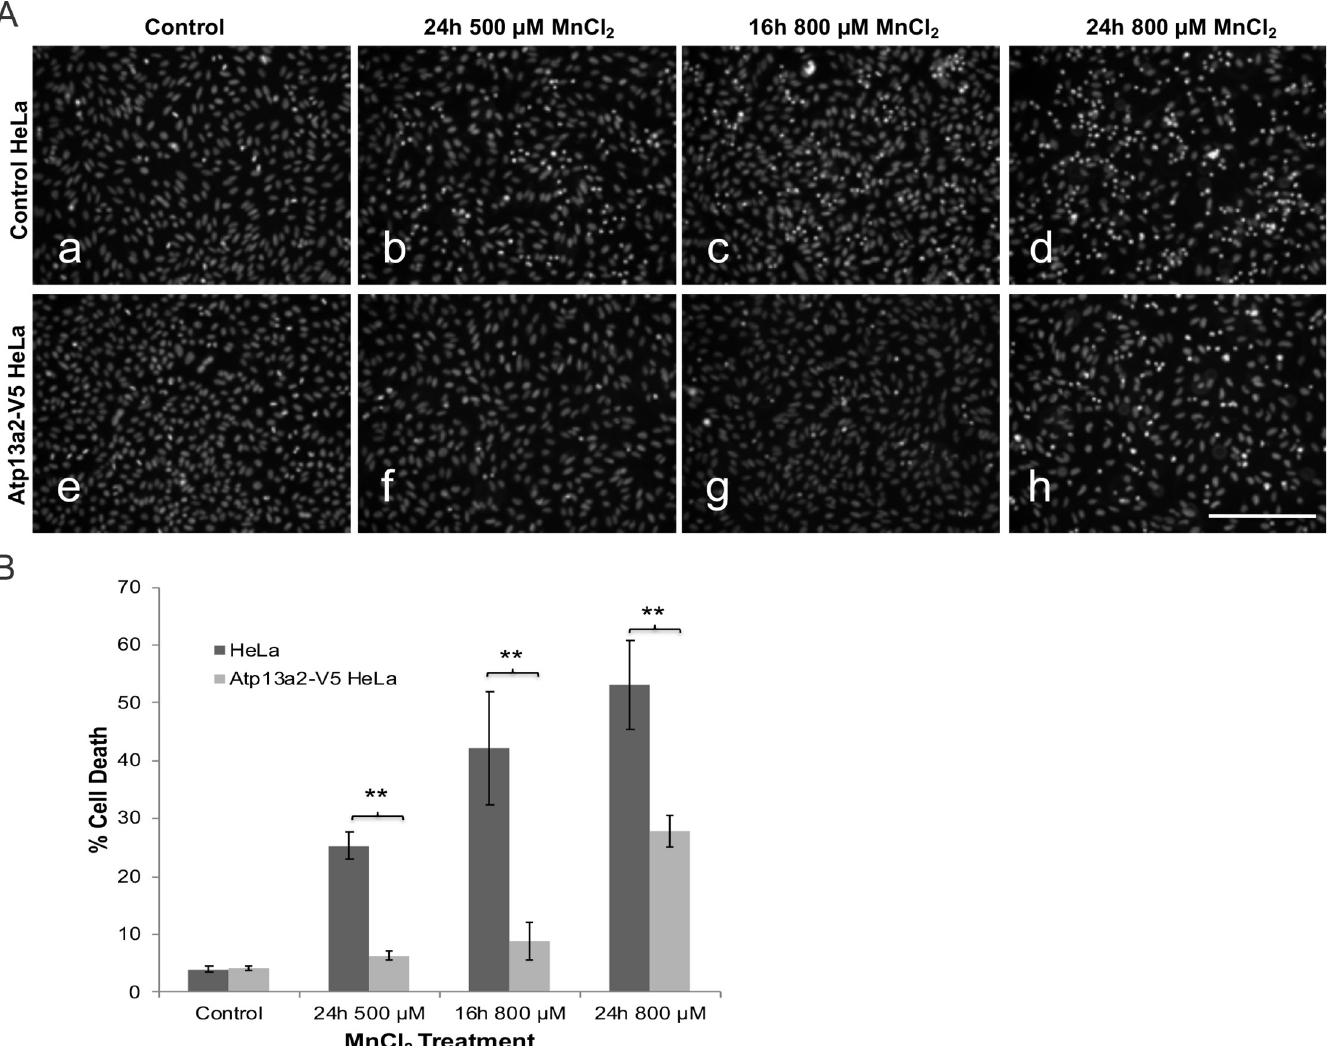
Fig 3. Overexpression of Atp13a2 protects cells from manganese cytotoxicity. (A-B) HeLa cells or HeLa cells stably expressing V5-tagged Atp13a2 were grown under normal growth conditions (a and e) or were exposed to 500 μ M (b and f) or 800 μ M MnCl 2 for 16 or 24 hours (c, d, g and h) prior to cell death analysis. Cell death was quantified by Hoechst 33342 staining. (A) Representative Hoechst staining of HeLa cells after MnCl 2 treatment. Bar, 100 μ m. (B) Quantification of cell death. Graph is representative of three independent experiments and data is shown as mean ± SDM. Cells expressing Atp13a2 show a significant decrease in cell death compared to normal HeLa cells after exposure to MnCl 2 . ( �� p <